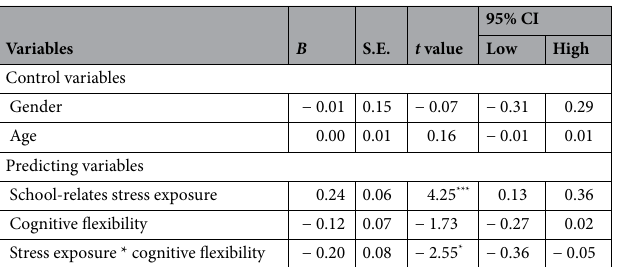
Table 2. The interactive effect of school-related stress exposure and cognitive flexibility on PTSD symptoms severity (estimated coefficients, standard errors, and 95% confidence intervals). CI confidence interval. ** p < 0.01, *** p <